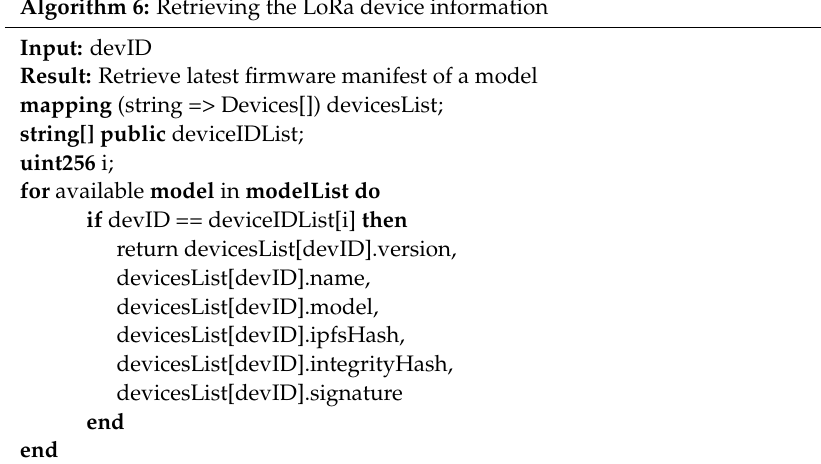
Algorithm 6: Retrieving the LoRa device